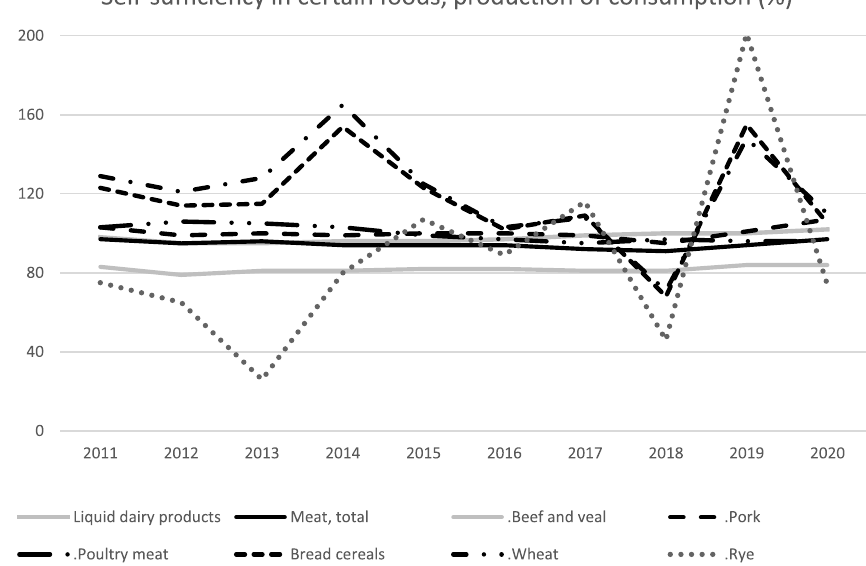
Fig. 1 Food self-sufficiency in Finland [7]. Self-sufficiency in certain foods, production of consumption